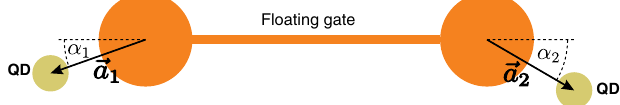
FIG. 8. The misalignment angle (cid:5) of the two QDs (yellow discs), defined with respect to the metallic floating gate